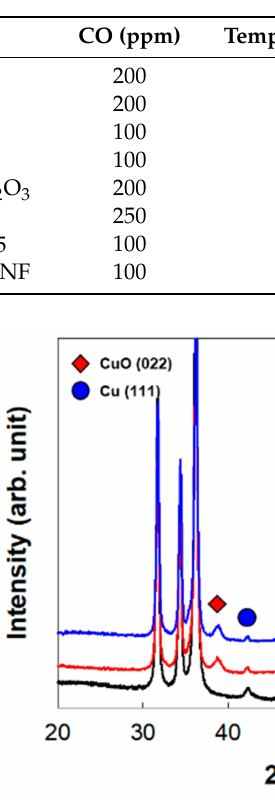
Figure 7. XRD patterns of as-prepared Cu / CuO(0.5 mM)@ZnO HNF and sample after annealing in air at di ff erent temperatures for 30 min. Red diamond, characteristic peak of CuO (022); blue circle, characteristic peak of Cu